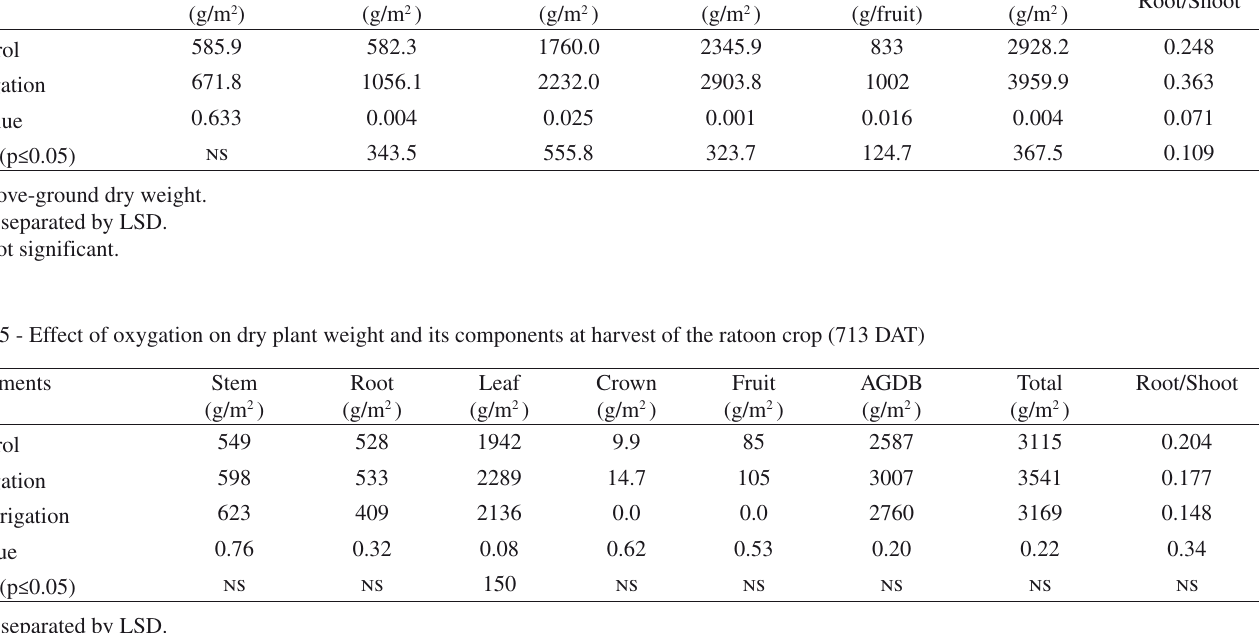
Table 4 - Effect of oxygation on plant dry weight and its components at the sample harvest of the main crop (392 DAT) from irrigated control and oxygation treatments (no irrigation treatments were not sample harvested in main crop) Treatments